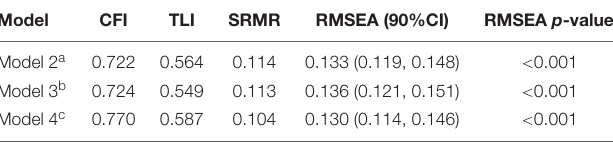
TABLE 3 | Model Fit Indices for model of Model 2 to Model